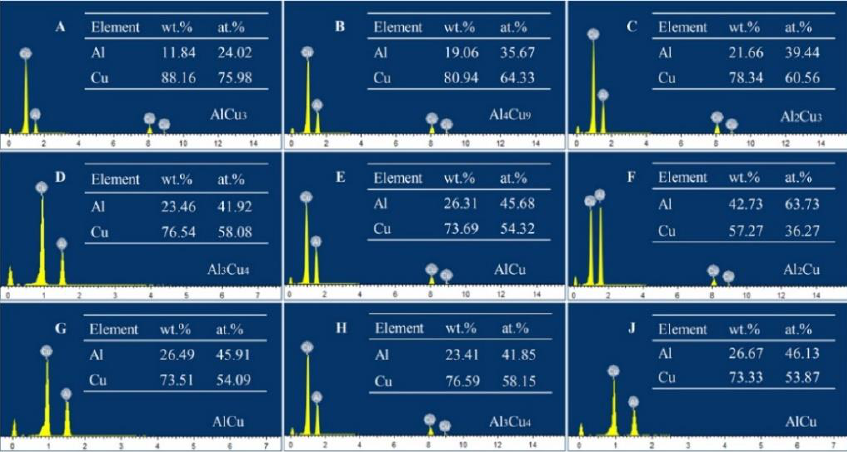
Figure 6. Composition analysis of interfacial microstructures (the phases ( A – J ) in Figure 5d – e) in Al/Cu sample by EDS.